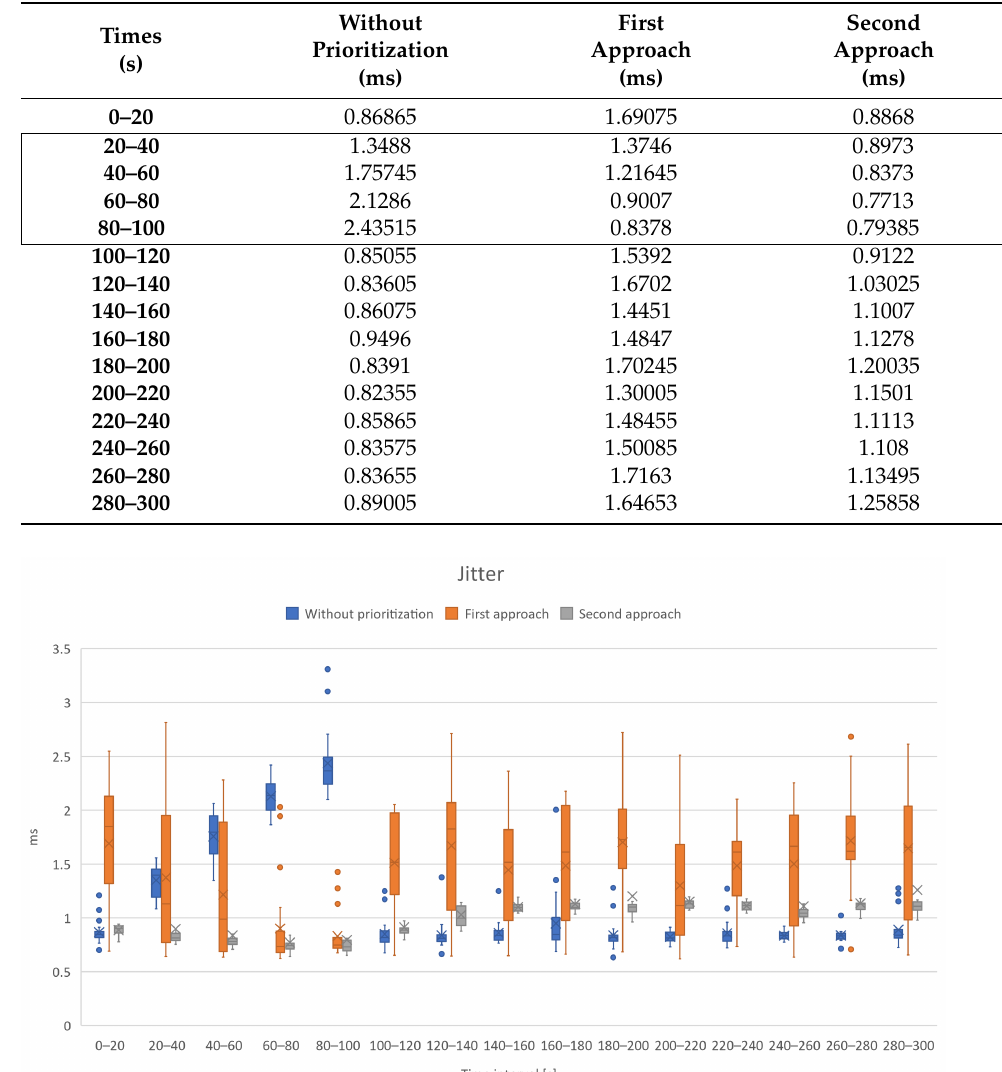
Figure 12. Comparison of the jitter obtained between the approaches considered (Control traffic